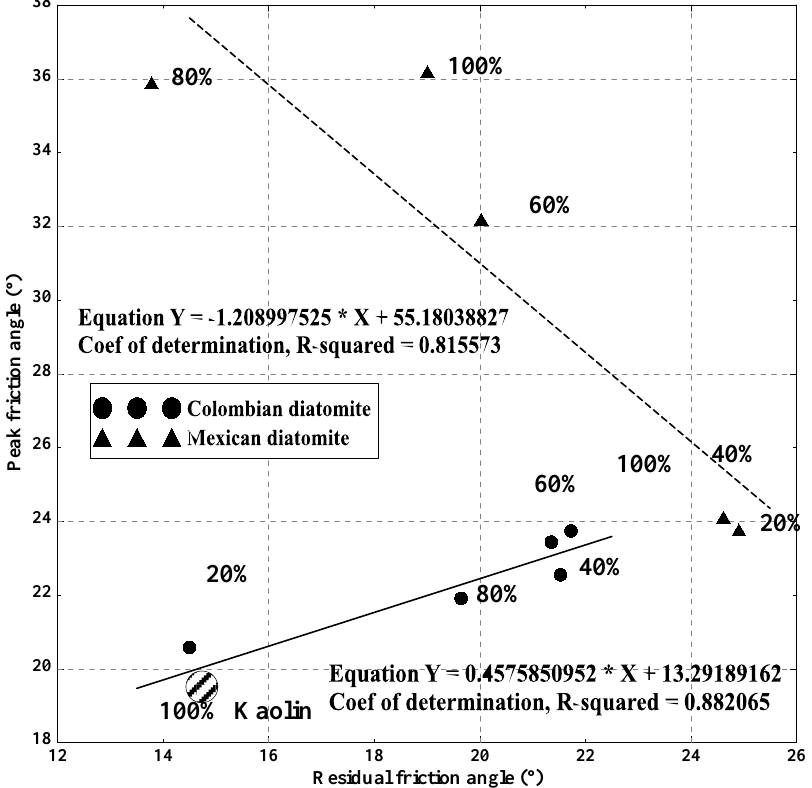
Figure 10. Correlation between peak and residual friction angle.